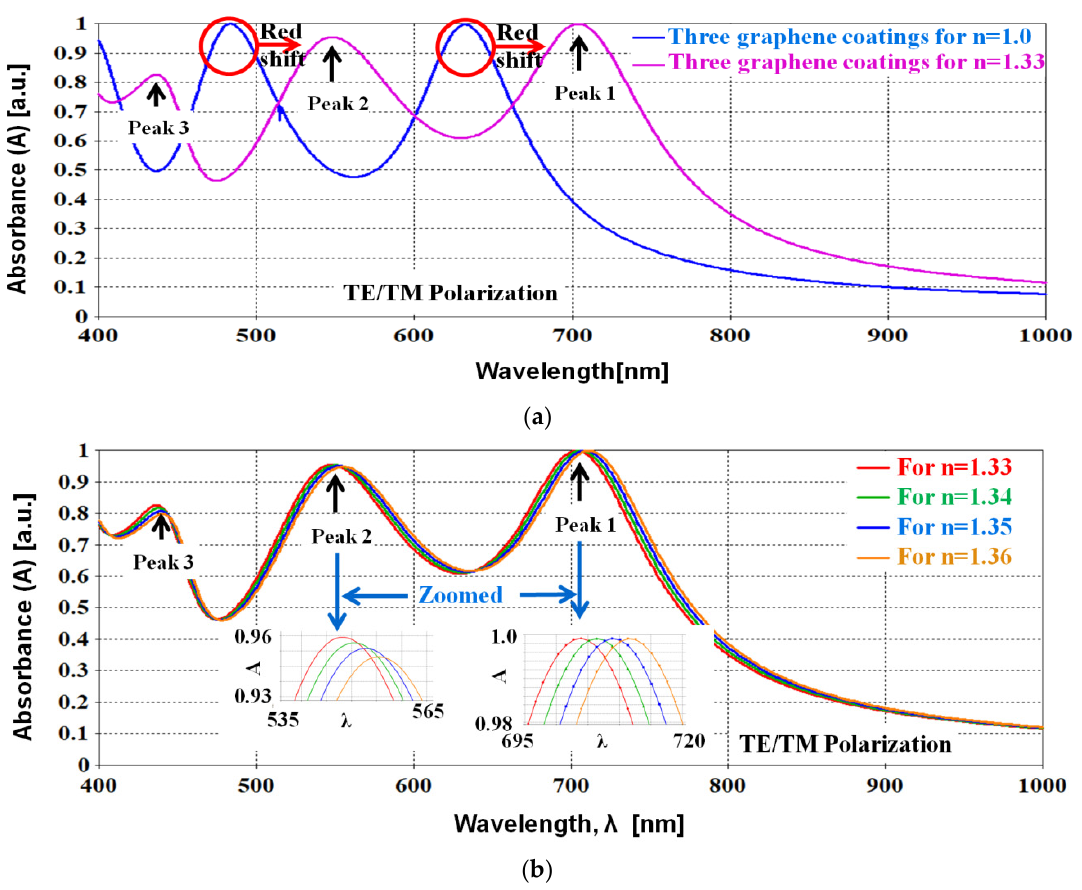
Figure 4. Absorbance spectra for different RI (n): ( a ) 1.0 and 1.33; ( b ) 1.33 to 1.36 (insets show the zoomed pictures of both peaks, left (peak 2), right (peak 1)).